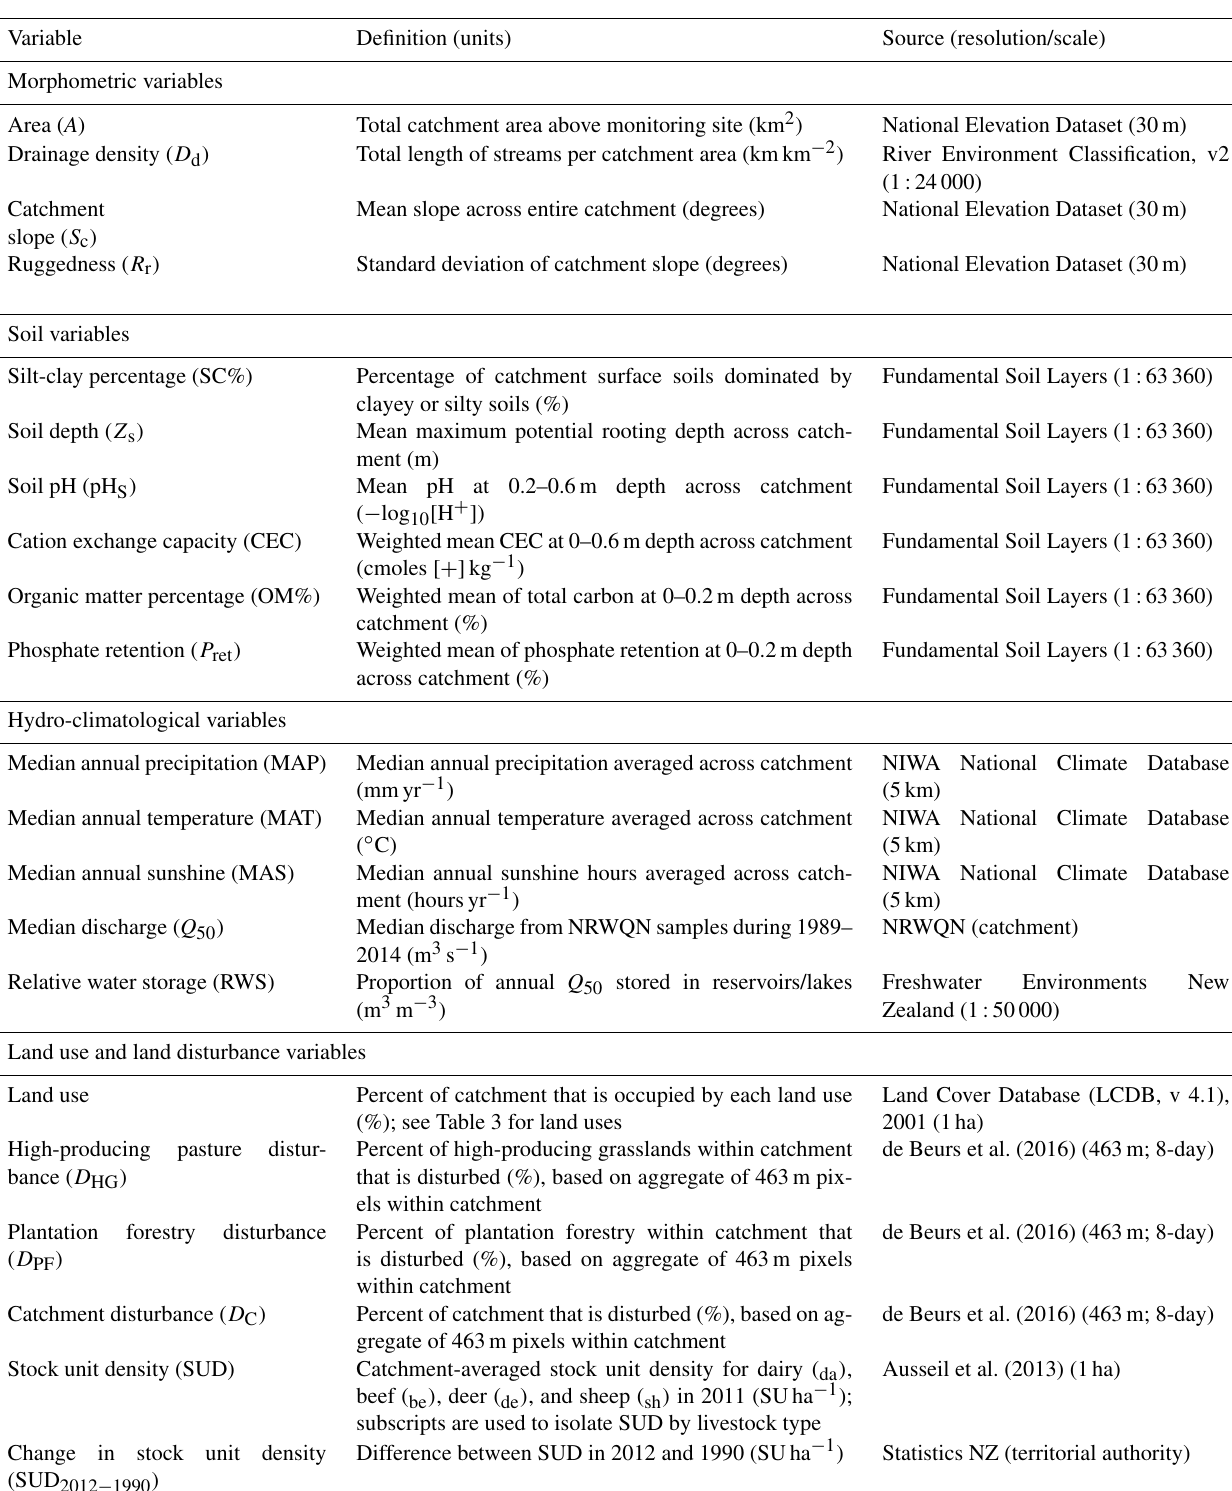
Table 2. Landscape variables characterizing the 77 catchments of the National River Water Quality Network (NRWQN). More details on sources for these data can be found in Methods